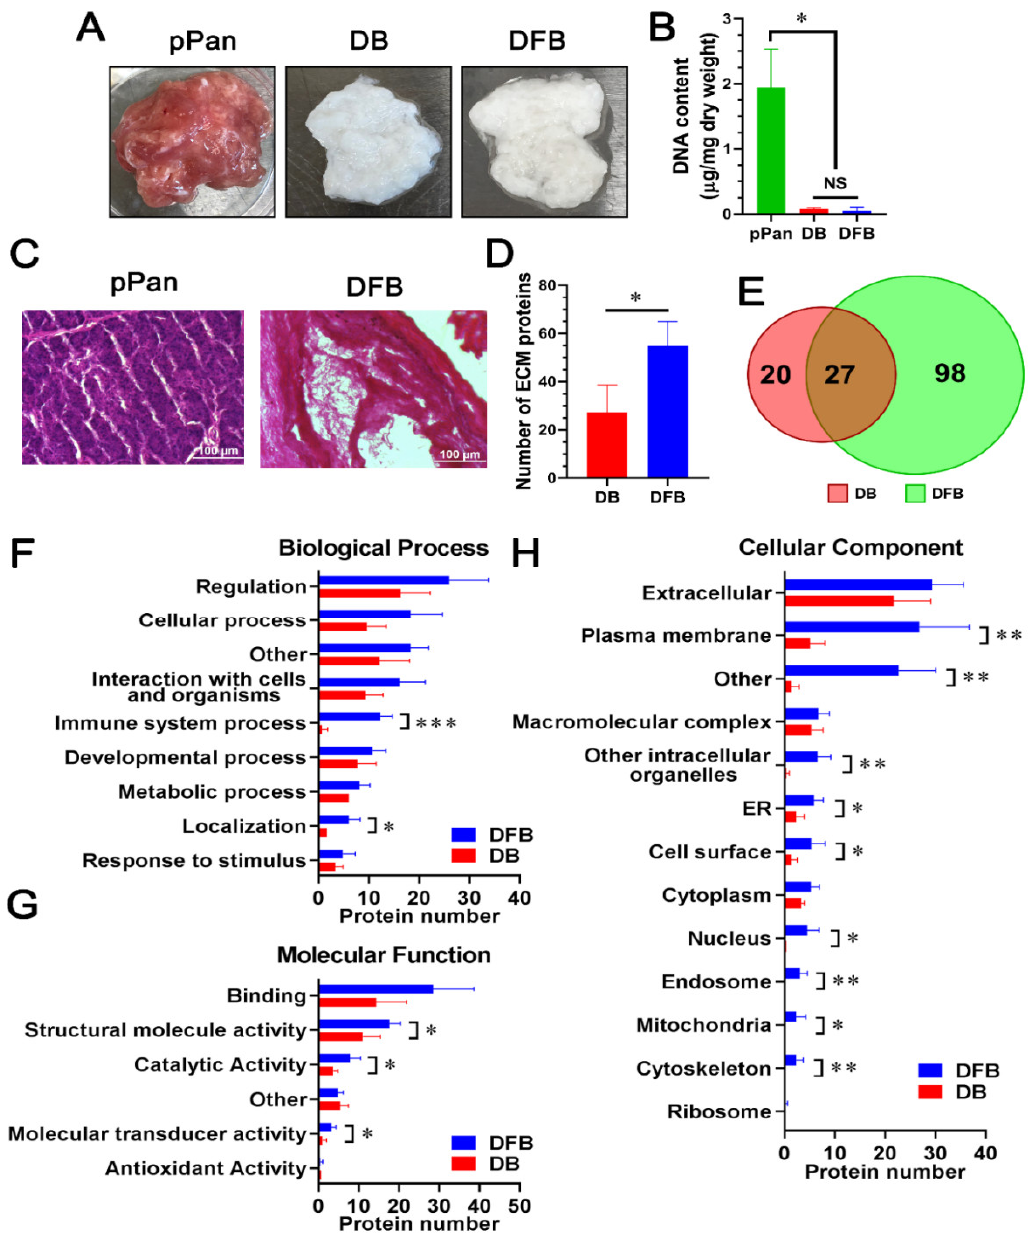
Figure 1. Comparison of detergent-free with detergent-based decellularization of porcine pancreata. ( A ) Porcine pancreatic tissues before (pPan) and after decellularization using a detergent-based (DB) or detergent-free method (DFB). ( B ) DNA content of pPan ( n = 6), detergent-based ( n = 3) or detergent-free ( n = 6) dpECM. *: p < 0.05; NS: not significant. ( C ) H&E staining showing porcine pancreatic tissue morphology before (pPan) and after decellularization (DFB) with a detergent-free method. Scale bars: 100 μm. ( D ) Average numbers of extracellular proteins identified from detergent-based or detergent-free dpECM. *: p < 0.05. ( E ) Venn diagram showing the total numbers of extracellular proteins identified in the dpECM. ( F – H ) Gene ontology enrichment analysis of extracellular proteins identified in the dpECM assigned to biological process ( F ), molecular function ( G ), and cellular component ( H ). *: p < 0.05; **: p < 0.01; ***: p < 0.001. Data are shown as mean ± SD.